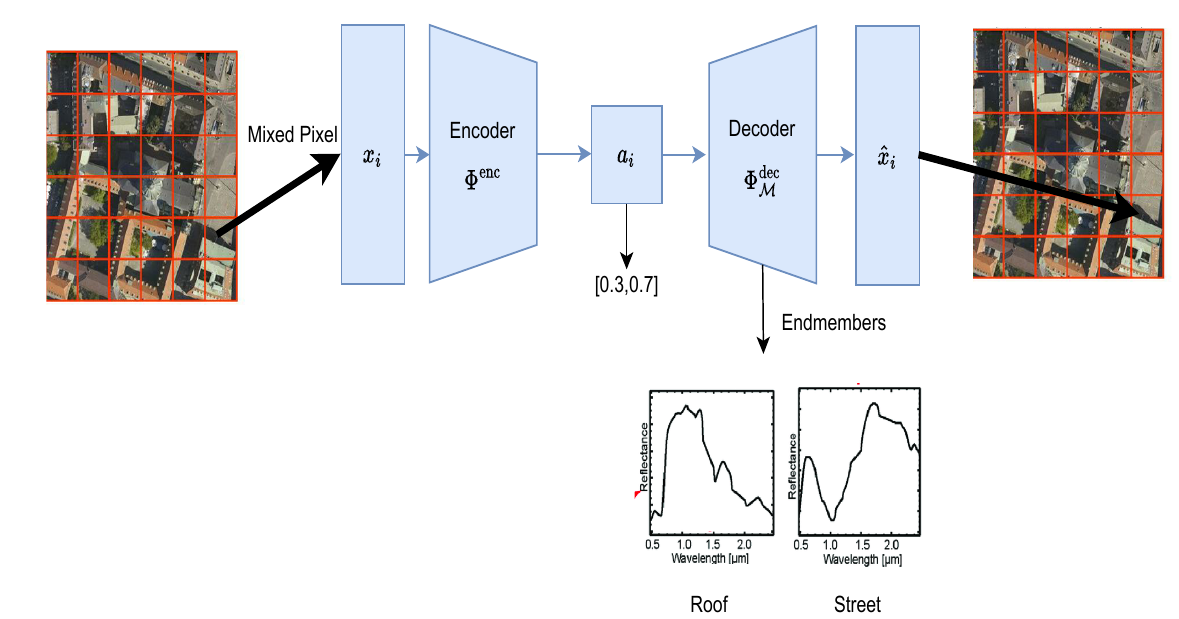
Figure 1. Representation of hyperspectral unmixing using an